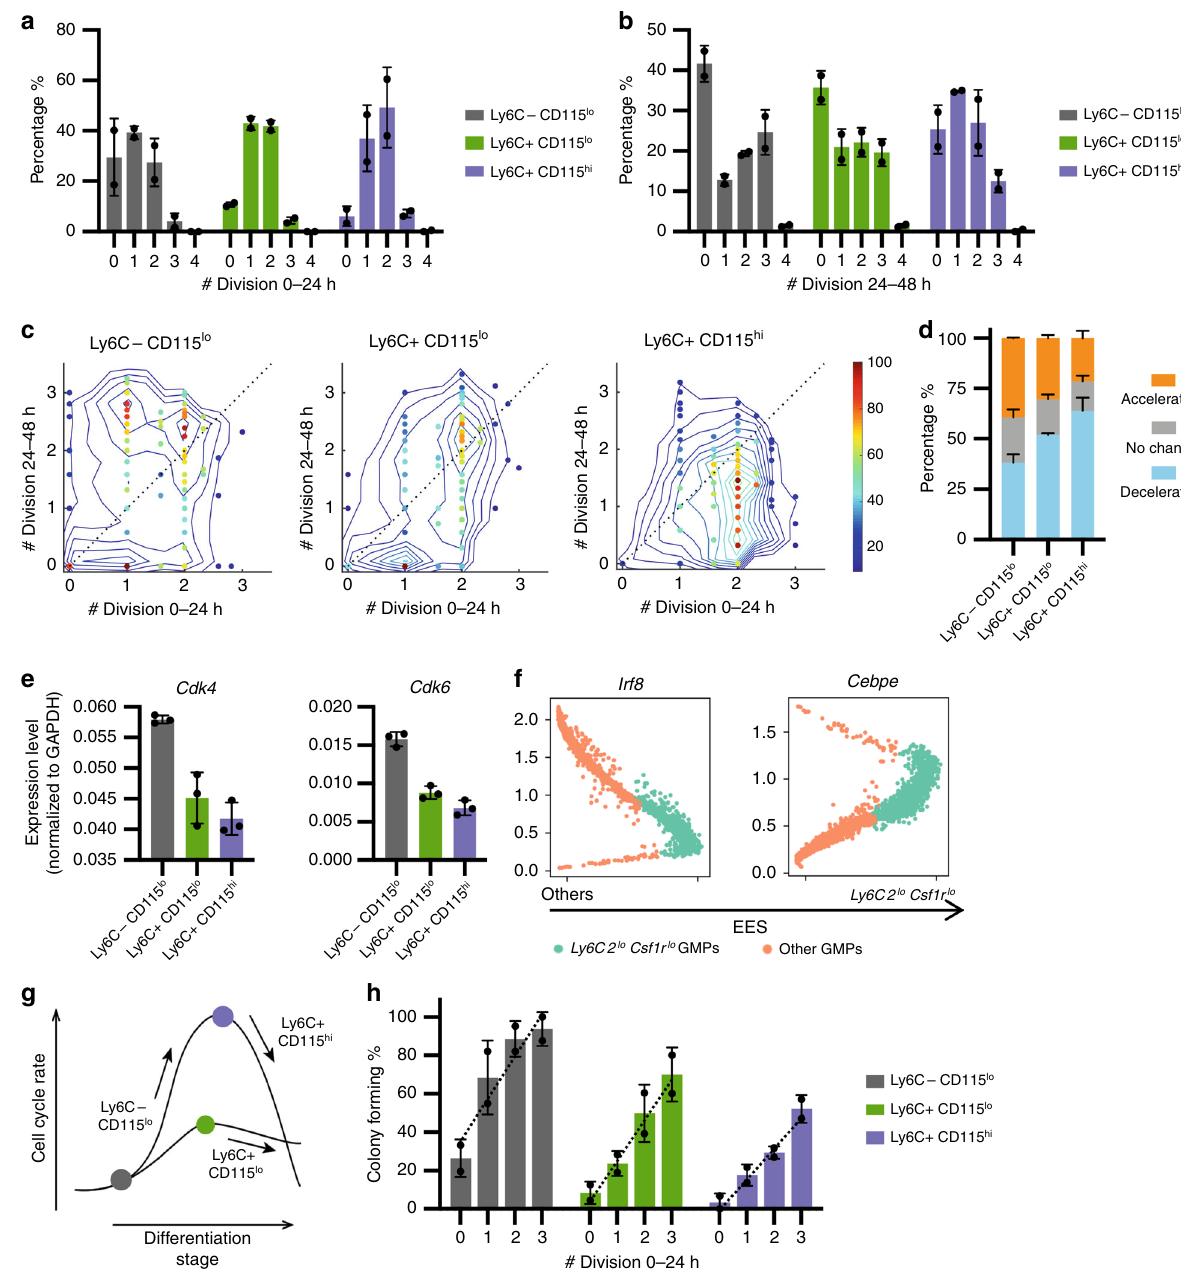
Fig. 8 Ly6C − CD115 lo GMPs are further enriched for MLL-AF9-mediated transformation. a Cell cycle rate distributions of the GMP subpopulations during 0 – 24 h of culture, in the absence of Dox ( n = 2). b Cell cycle rate distributions of the GMP subpopulations during 24 – 48 h of culture, in the absence of Dox ( n = 2). c Cell cycle rates of individual cell lineages during 48 h of culture. Number of divisions during 0 – 24 h of culture ( x -axis) were plotted vs those